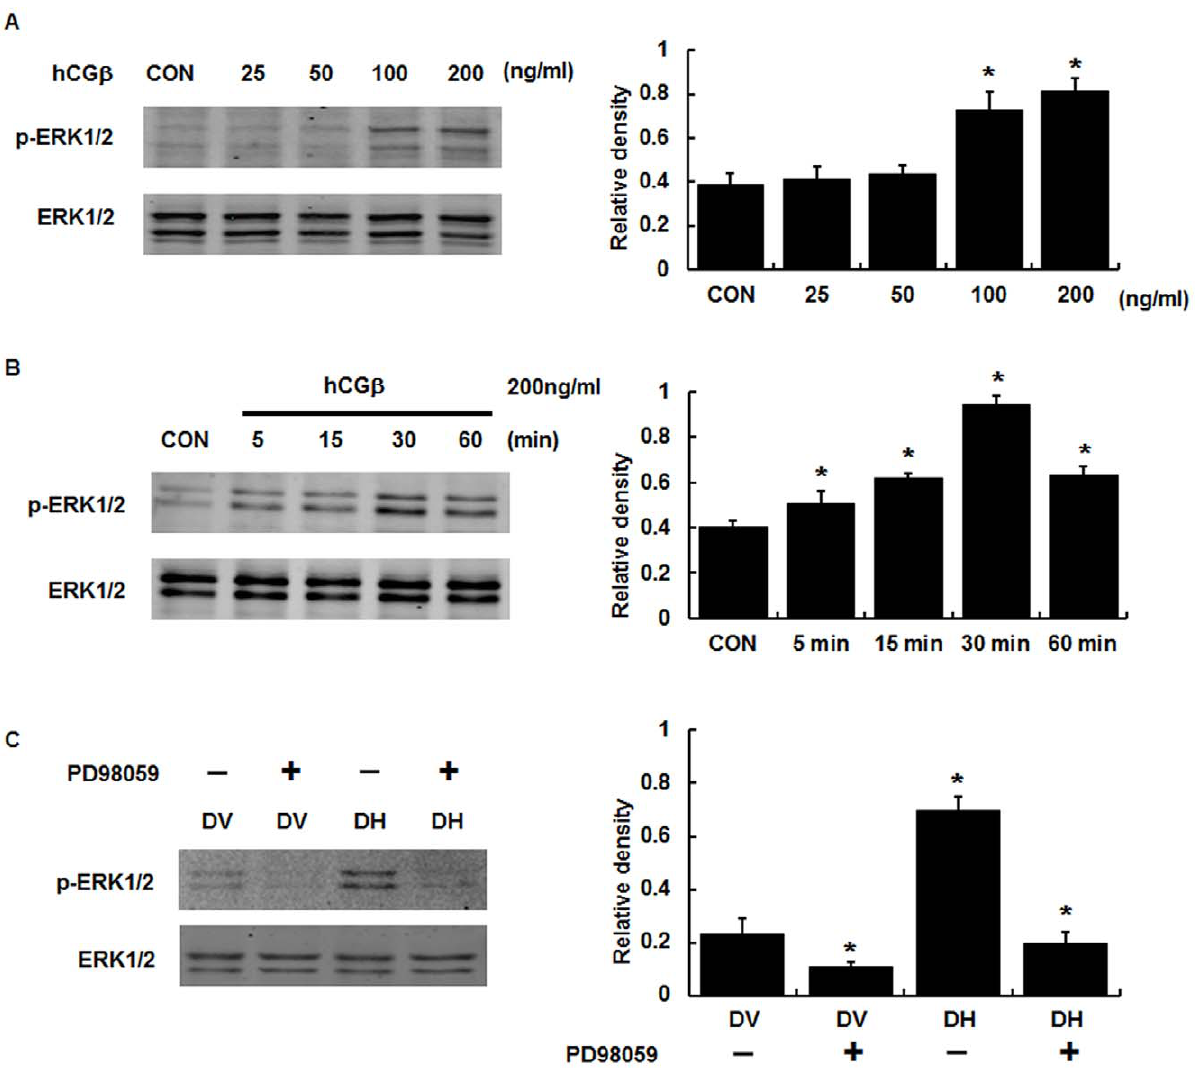
Figure 3. HCG phosphorylated ERK1/2. (A)We have demonstrated that the concentration of 200 ng/ml hCG b standards induced cell invasion [11]. Thus, here we treated non-transfected DU145 cells with different doses of 0, 25, 50, 100, and 200 ng/ml hCG b for 1 h. Western blot showed that hCG b standards phosphorylated ERK1/2 in a dose-dependent trend. At the concentration of 200 ng/ml, ERK1/2 activation reached the peak. (B) Non- transfected DU145 cells in serum-free medium were treated with 200 ng/ml hCG b for 0, 5, 15, 30 and 60 min. Western blot showed that hCG b activated ERK1/2 in a time-dependent manner. At the time point of 30 min, ERK1/2 phosphorylation reached the peak and then went down. (C) The cells were pretreated with PD98059 (25 m M) 30 min and then incubated for 24 h in serum-free medium, Western blot showed that hCG b activated ERK1/2, but PD98059 decreased ERK1/2 activation. *, indicates P , 0.05 versus DV. Data were shown as means 6 SEM from three separate tests.